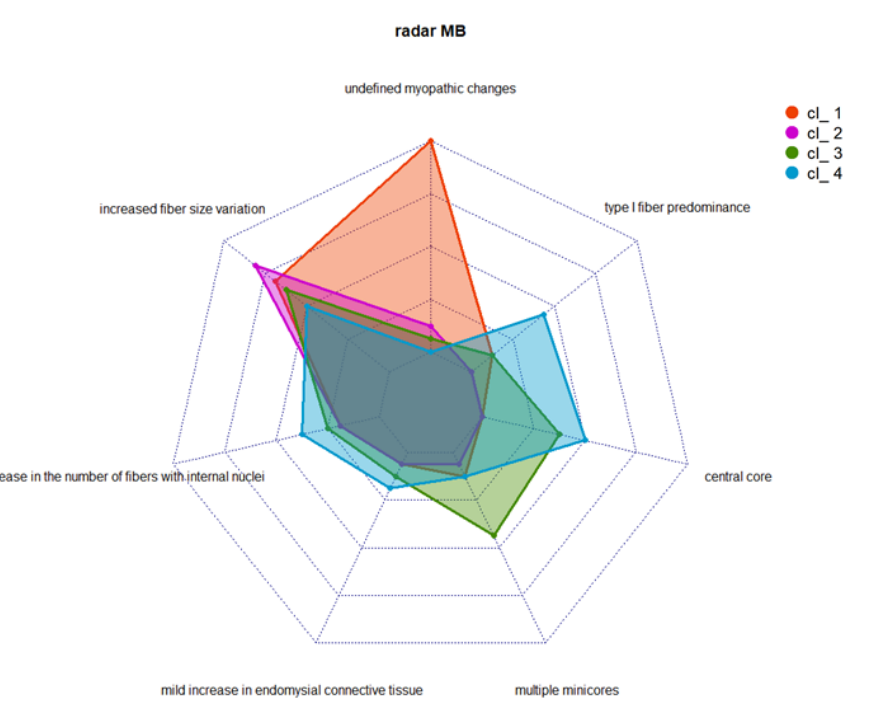
Figure 5. Distribution of frequencies of muscle biopsy (MB) findings, shown per cluster.